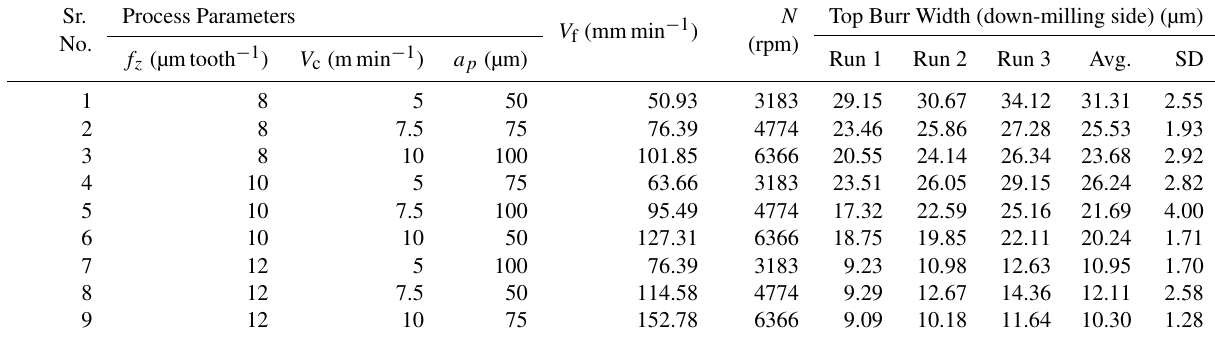
Table 6. Taguchi orthogonal array (L9 array) for micro-milling of Ti-6Al-4V. Sr.